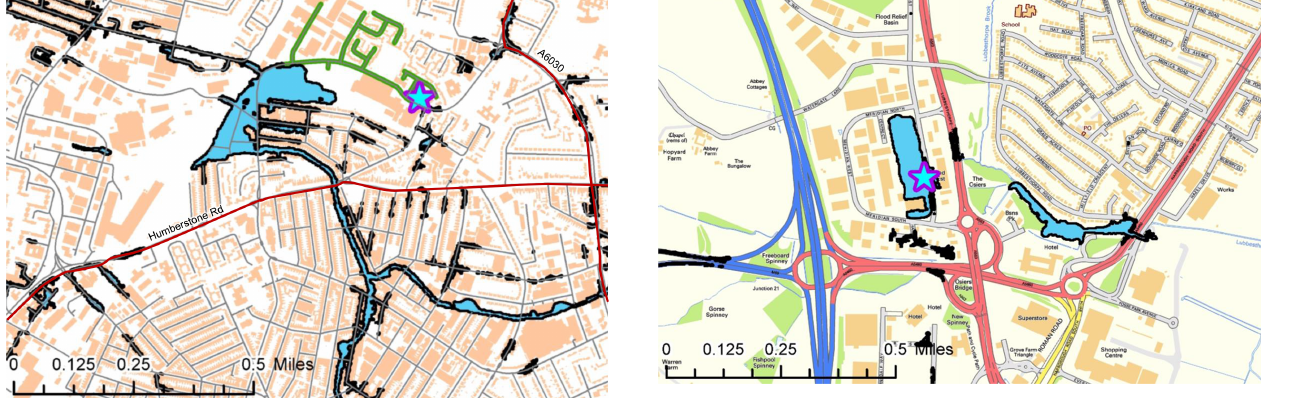
Figure 9. The Eastern Fire and Rescue Station during a 1 in 100- year flood event shows the surrounding roads experiencing inunda- tion, predominantly surrounding Willow Brook (centre). The green line indicates the accessible road network without mitigation mea- sures. Floodwaters surrounding Willow Brook were removed at the Humberstone Road intercept because a large bridge passed over the brook. Floodwaters blocking access to the A6030 were also re- moved since these would likely be pumped.